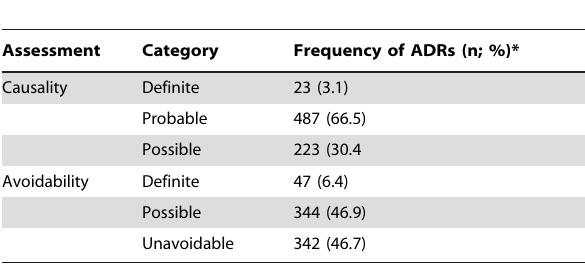
Table 4. Causality and avoidability assessments of the adverse drug reactions in hospital